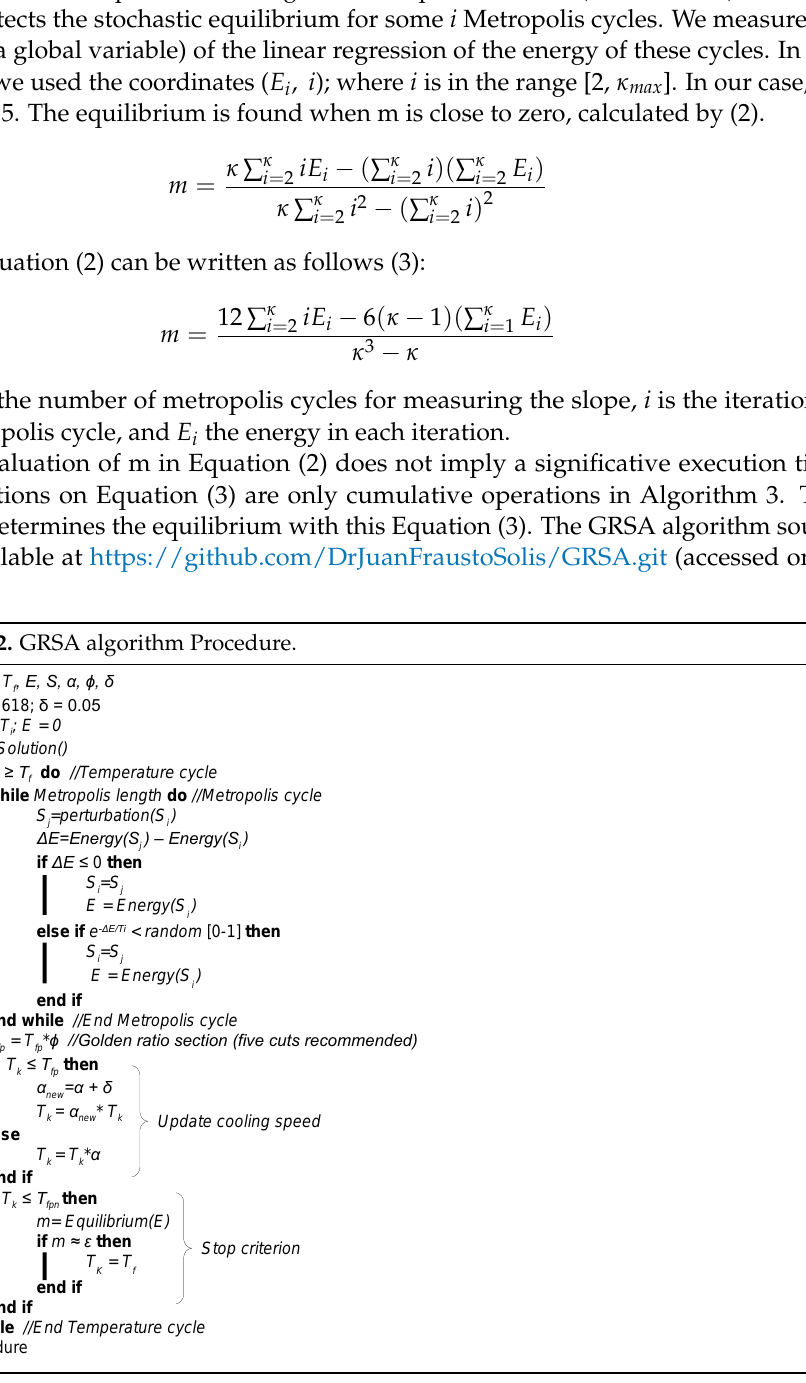
Algorithm 2 GRSA algorithm Procedure 1: Data: T , T , T , E, S, α, ϕ, δ i fp f